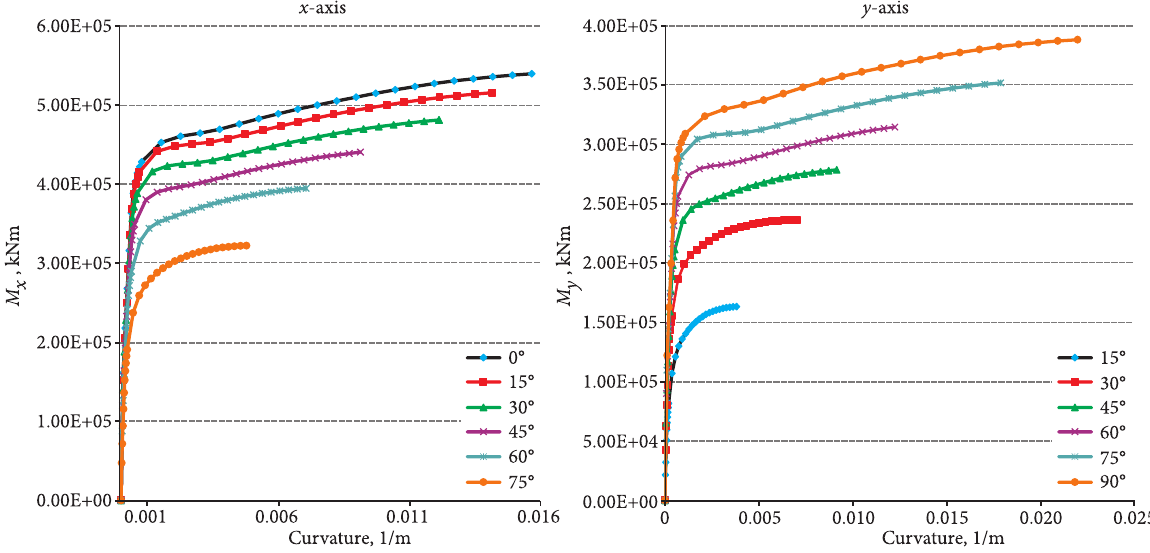
Fig. 16. M– φ curve with different